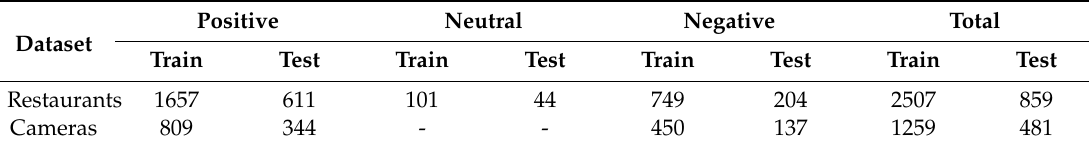
Table 1. The Summary statistics of the two datasets. Restaurants is an English dataset, whose sentiment polarity is positive, neutral and negative. Cameras is a Chinese dataset, whose polarity is positive and